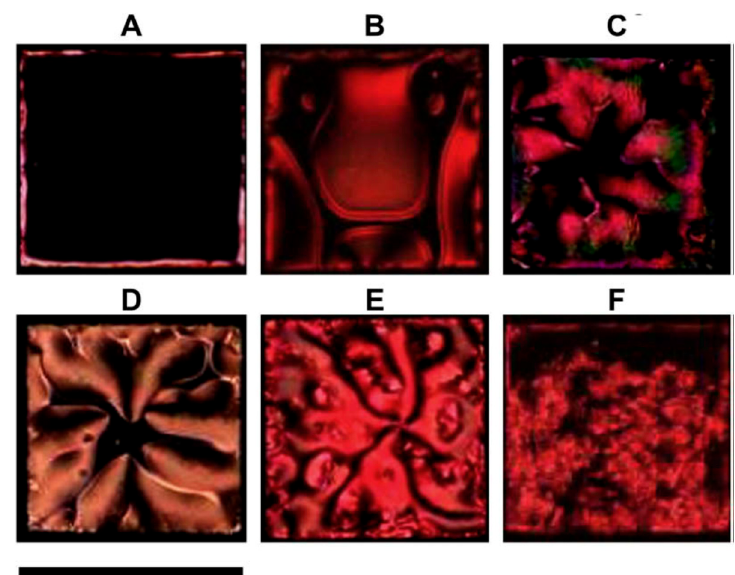
Figure 11. Interaction of a L -DLPC monolayer self-assembled at the aqueous-LC interface with solutions containing protein-coated Au NPs. Optical images of 5CB (crossed polarizers) captured ( A ) within 5 min after immersion of L -DLPC monolayer into AuNPs, ( B ) after 40 h contact of the L -DLPC with 50 nM of BSA-coated Au NPs, ( C ) after 60 h contact of the L -DLPC with 20 nM of BSA-coated Au NPs, ( D ) after 90 h contact of the L -DLPC with 2 nM of BSA-coated Au NPs, ( E ) after 32 h contact of the L -DLPC with 50 nM of neutravidin-coated Au NPs, and ( F ) after 2 h contact of the L -DLPC with 50 nM of fibrinogen-coated Au NPs. Scale bar = 283 mm. Reproduced with permission from Ref. [51]. (Elsevier).